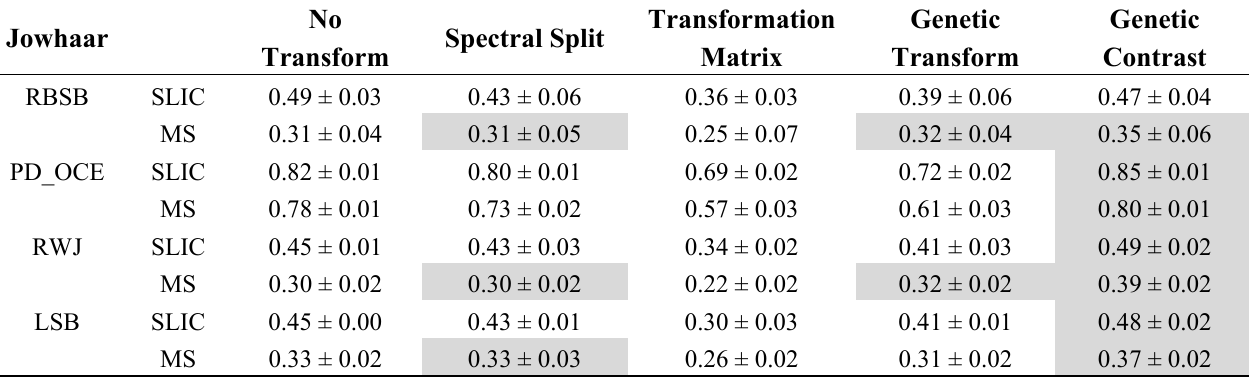
Table 2. Jowhaar site results.